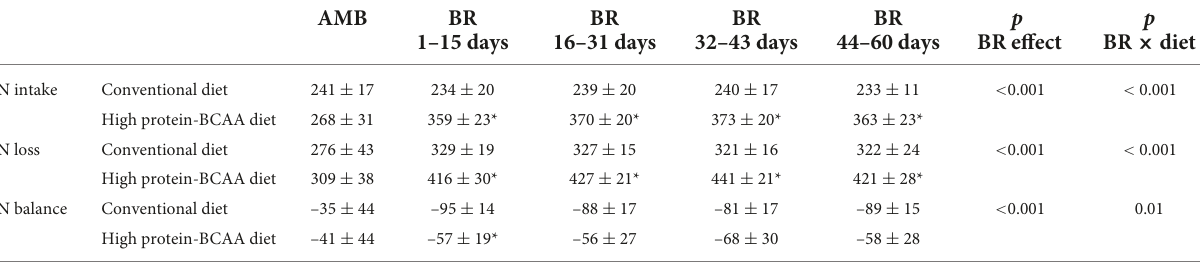
TABLE 3 Nitrogen (N) intake, loss and